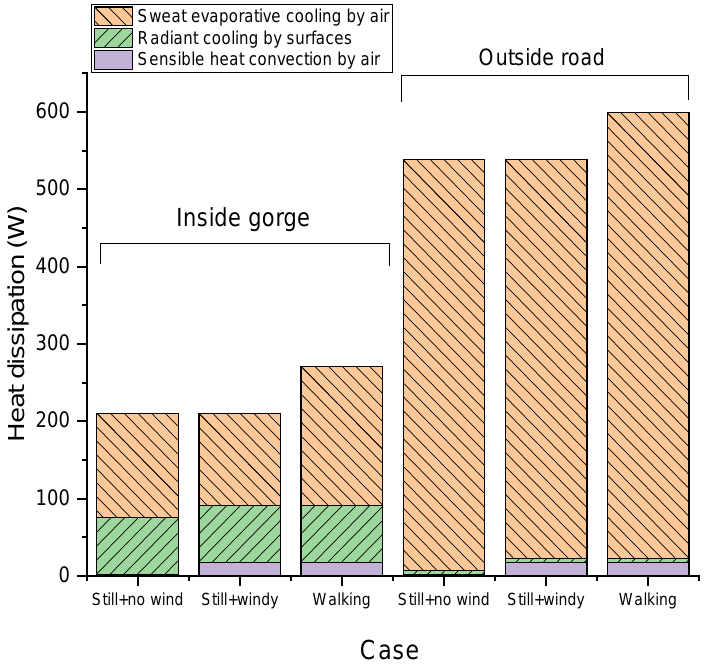
Figure 12. Total heat gain and dissipation of the human body.